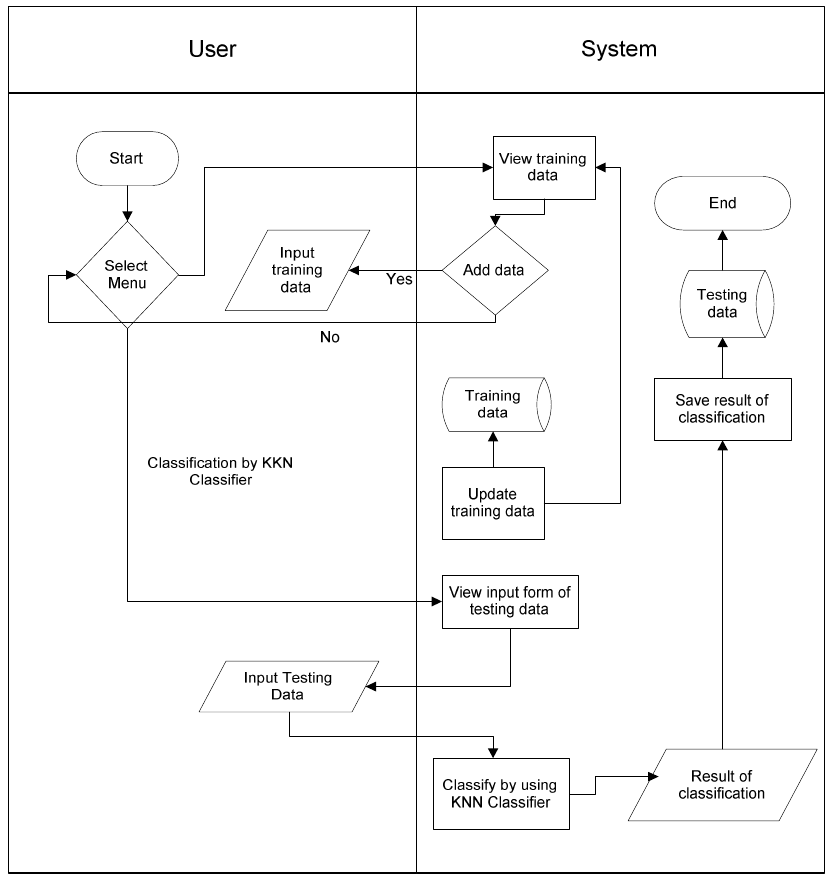
Fig. 1 System flow diagram for classification using